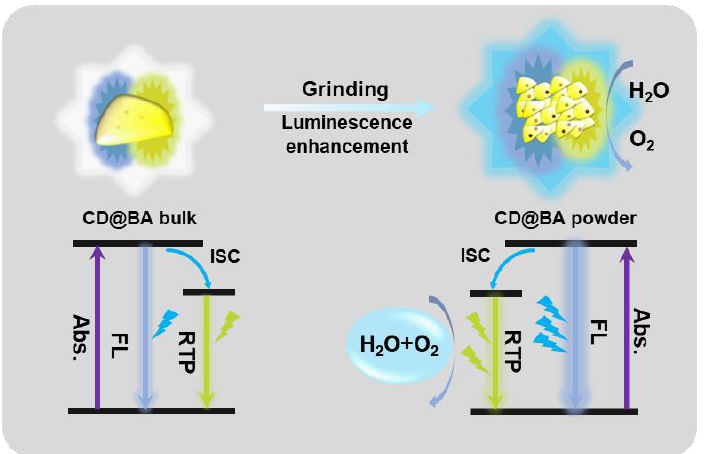
Figure 4. Schematic of the proposed force-induced color-variable luminescence mechanism of CD@BA composites. Abs., absorption; FL., fluorescence; RTP, room temperature phosphorescence. CD@BA powder has promising potential in fingerprint detection technology; it